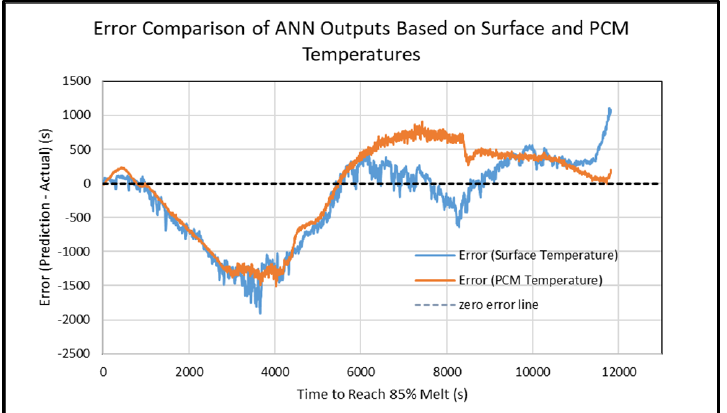
Figure 16. Comparison of error in predictions from the ANN model trained using transient surface- temperature data and transient PCM-temperature data (for test data set of 2.6 V and training data set of 2.3 V).